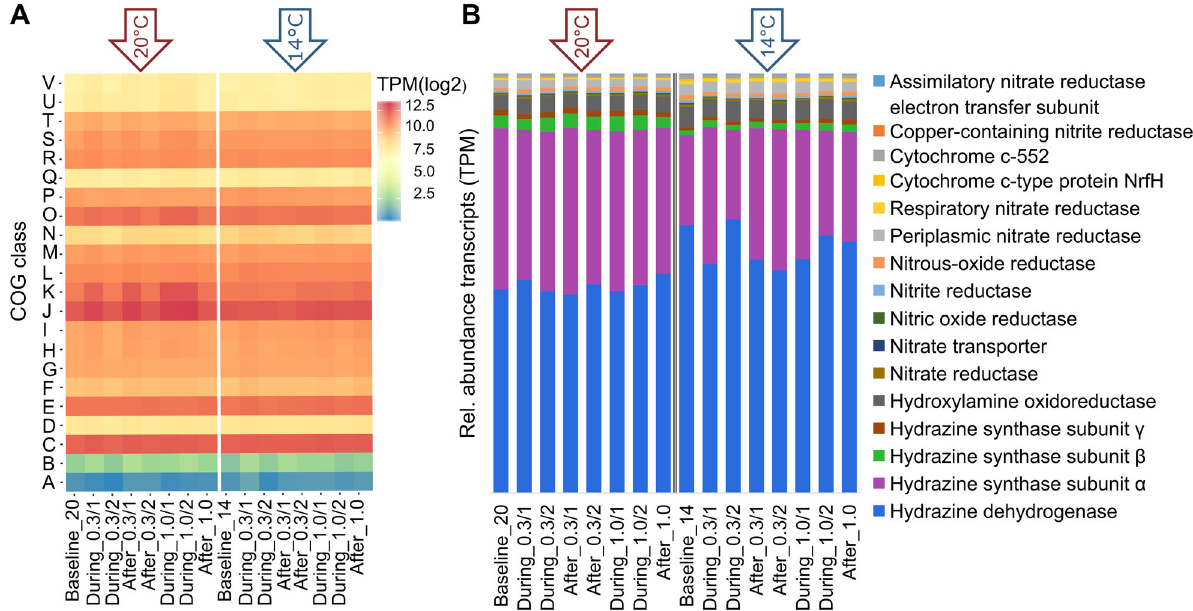
Fig. 5 Transcriptomic differences on functional level. A Heatmap based on the cumulated transcripts per million (log2) from all genes falling into certain cluster of orthologs (COG) categories ( y -axis). Time-points ( x -axis) are based on the averaged reactors ( n = 3). B Relative abundance of transcripts in TPM of genes involved in the nitrogen cycle. The left part shows the 20 °C samples, the right part the 14 °C experiment, as indicated by the